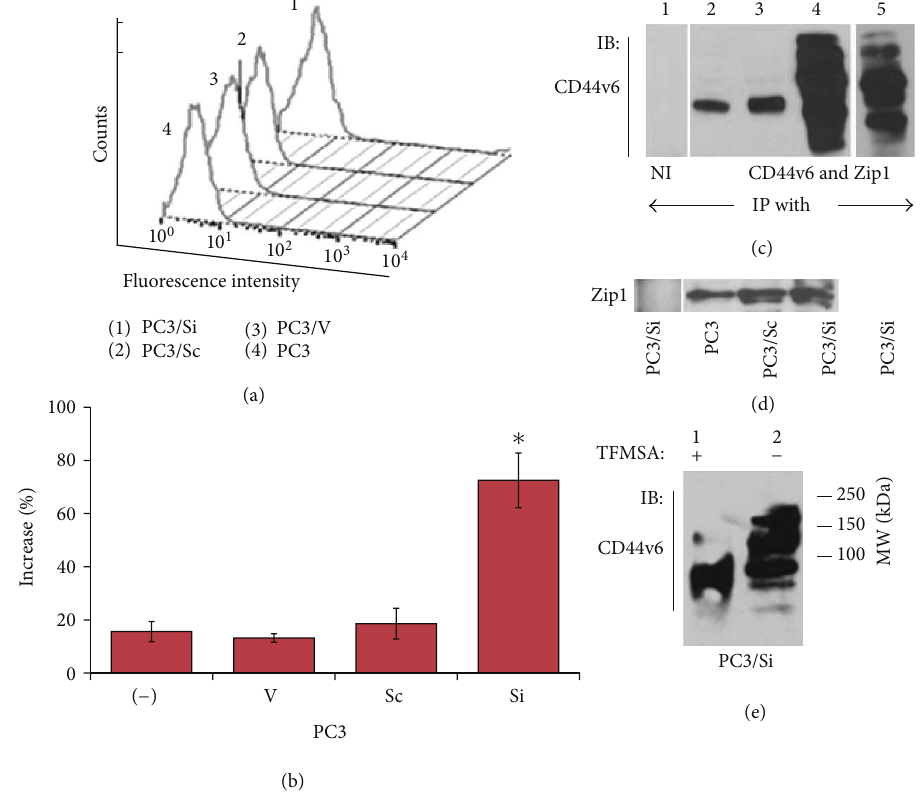
Figure 2: Analysis of surface expression of CD44v6 in indicated PC3 cell lines. (a) and (b), Surface expression of CD44v6 in PC3 cells knockdown of MMP9 (PC3/Si) is compared with control cell lines (PC3, PC3/V, and PC3/Sc) by FACs analysis (a) and (b). A representative histogram demonstrating the surface levels of CD44v6 in various PC3 cell lines is shown. In a typical experiments about 4–6 wells in 24 wells were used for each cell line. Statistical analysis of the mean fluorescence intensity (mean ± SEM; 𝑛 = 3 ) is shown as a graph (b); ∗ 𝑃 < 0.0001 versus control cell lines. (c) and (d) Immunoblotting analysis of surface expression of CD44v6 and Zip1 proteins in indicated PC3 cell lines. Equal amount of lysate proteins (100 𝜇 g) were immunoprecipitated with an antibody to CD44v6 (c) and Zip1 (d) and pulled down with streptavidin agarose. The blot was probed with a CD44v6 antibody followed by a Zip1 antibody after membrane stripping. A shorter exposure blot for PC3/Si is shown in lane 5. (e) Deglycosylation of CD44v6 with TFMSA. Total lysates (500 𝜇 g protein) made from PC3/Si cells were treated with (+) and without ( − ) TFMSA. Immunoblotting analysis demonstrates the deglycosylated (lane 1) and non-deglycosylated (lane 2) CD44v6 (e). The results shown are representative of three different